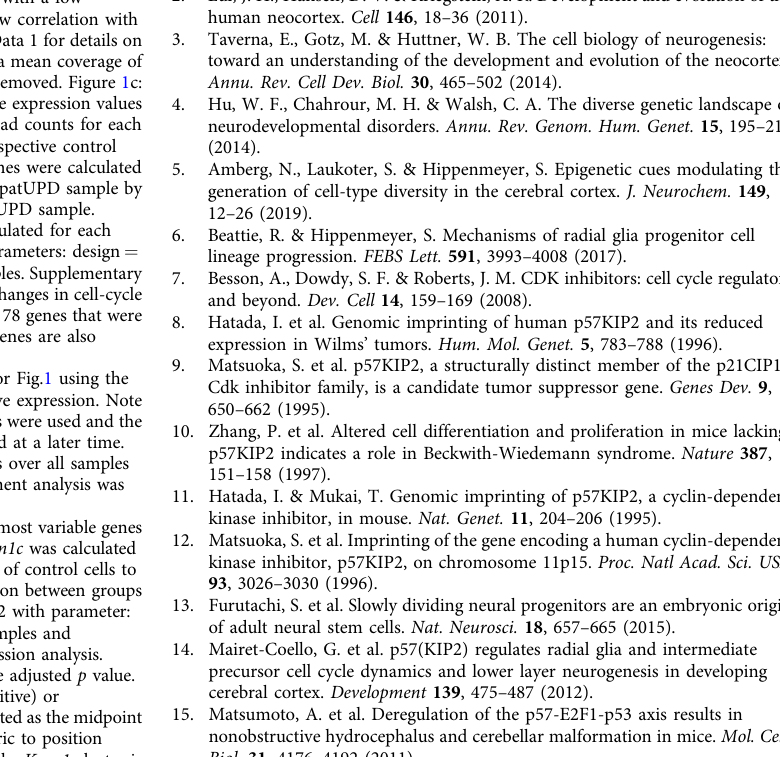
Figure 3: Relative expression of Cdkn1c was calculated as for Fig.1 using the mean normalized read count of control cells to calculate relative expression. Note Figure 4: Genes with a mean coverage of less than ten reads over all samples under investigation were removed. Figure 4b: Principal component analysis was performed on variance stabilized count data calculated by varianceStabilizingTransformation (DESeq2) using the top 500 most variable genes and parameter: blind = T. Figure 4c: relative expression of Cdkn1c was calculated and plotted as for Fig.1 using the mean normalized read count of control cells to calculate relative expression. Signi fi cance of differential expression between groups was calculated for each developmental time point using DESeq2 with parameter: design = ~group. Supplementary Data 3 provides details on samples and Supplementary Data 4 provides full results of differential expression analysis. Figure 4e: Signi fi cance scores were calculated as the log 10 of the adjusted p value. Pre fi x of this score was adjusted to represent upregulation (positive) or downregulation (negative). The position of each gene was calculated as the midpoint of its annotated genomic locus. Only informative genes telomeric to position 141459694 (mm10) are shown. The putative maximum size of the Kcnq1 cluster is